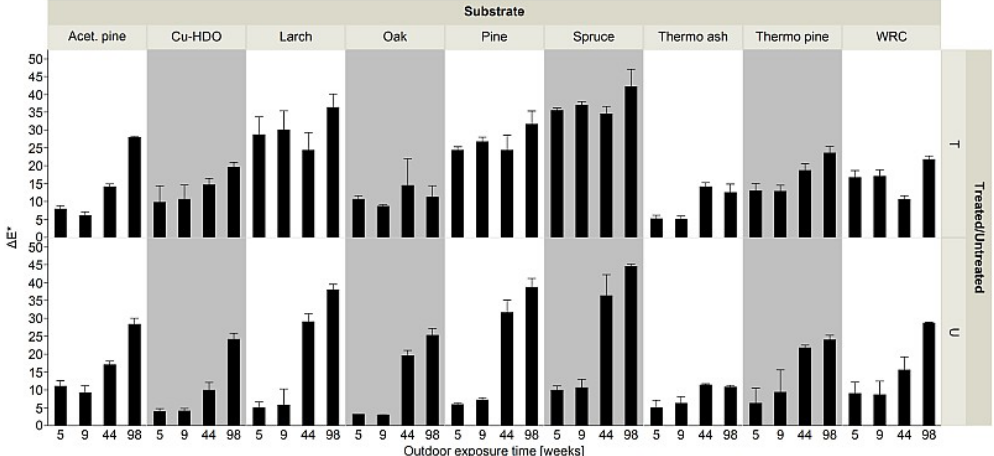
Figure 8. dE‐values of the substrates treated with iron (II) sulfate (upper row) and the untreated references (lower row) of sample set 3 after 5, 9, 44, and 98 weeks of outdoor exposure at 45° to the south. Cu‐HDO = Scots pine impregnated with Bis‐(N‐cyclohexyldiazeniumdioxy)‐copper; WRC = western red cedar.